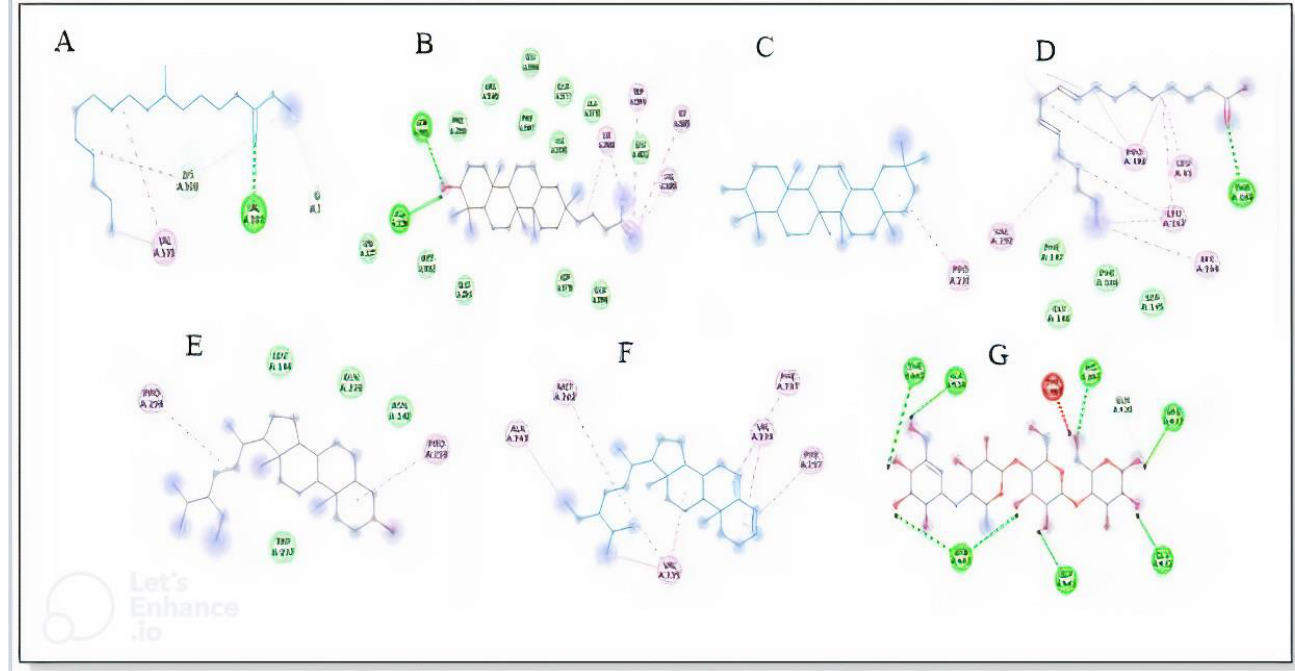
Figure 4. Enzyme α -glucosidase and ligands interaction. Hexadecanoic acid ( A ), Lupeol ( B ), β - Amyrin ( C ), Octadecadienoic acid ( D ), Sitosterol ( E ), Stigmasterol ( F ), Acarbose (standard) ( G ). Molecular docking on three key compounds (Lingstroside, Rutin, and Scutellarin) identified from the methanolic extract using LC-ESI-MS (Figure 6) was performed against mushroom tyrosinase enzyme. As a reference drug for such conditions, kojic acid was also included in the assay. The binding affinities and amino acid interactions are presented in Table 8 and Figure 7.